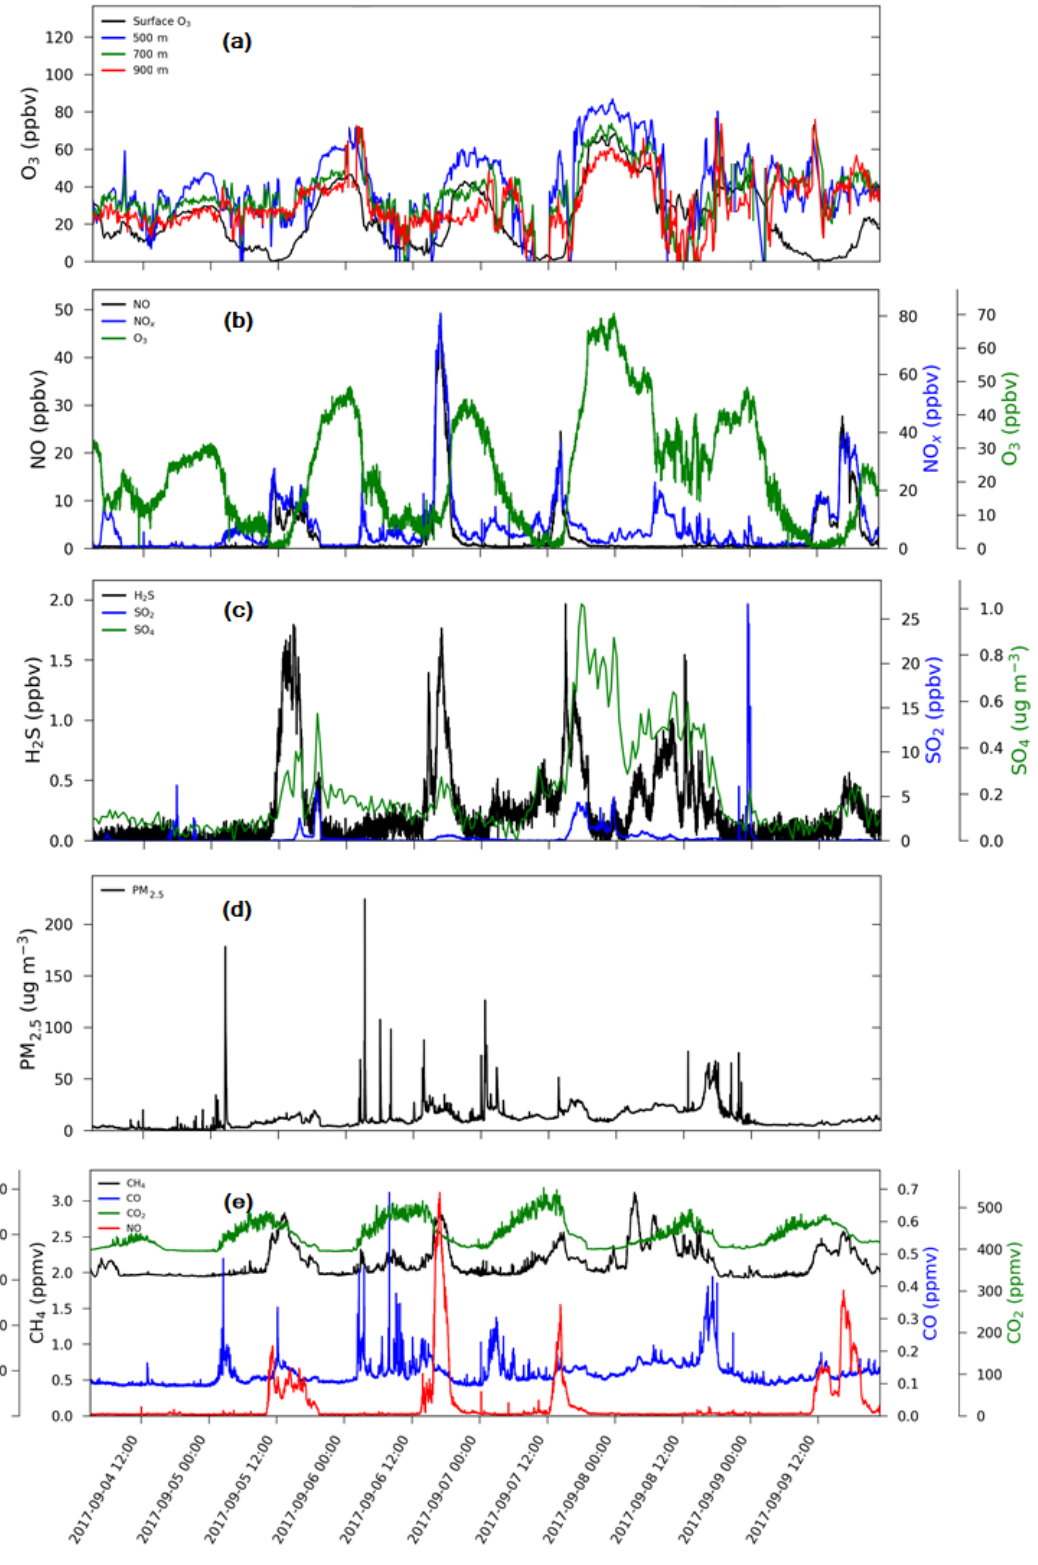
Figure 19. (a) DIAL ozone traces at different altitudes compared to surface ozone for the same period as Fig. 18. CAM1 surface measure- ments for same time period of (b) ozone and NO x ; (c) sulfur compounds; (d) PM 2 . 5 ; and (e) CH 4 , CO, CO 2 and